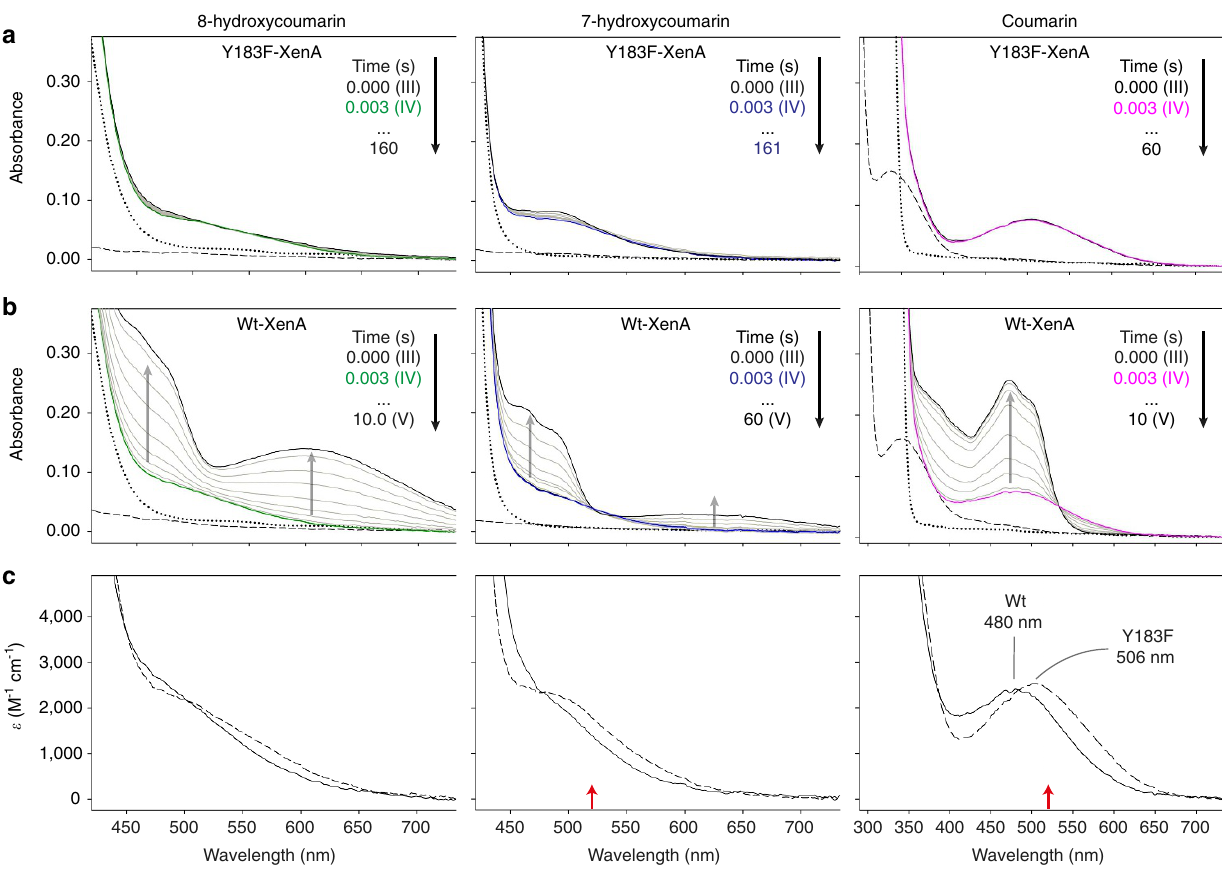
Figure 2 | Kinetics of the reoxidation of XenA. Time-dependent spectral changes for the reoxidation of 30 m M reduced ( a ) Y183F-XenA and ( b ) wild-type XenA by 8-hydroxycoumarin, 7-hydroxycoumarin and coumarin. The dashed and dotted lines represent the spectra of the reduced enzymes and substrate, respectively. Grey arrows indicate the direction of absorbance changes. The first spectra after 3ms represent the Michaelis complexes (IV) of the oxidative half-reaction with 8-hydroxycoumarin (green), 7-hydroxycoumarin (blue) and coumarin (pink), respectively. The black bold spectra, obtained after complete reoxidation of reduced wt-XenA, correspond to the non-productive Michaelis complex mimics (V). ( c ) Spectral overlay of the reaction intermediates (Michaelis complexes; IV) of wt-XenA (solid-line) and Y183F-XenA (dashed line). The bathochromic shift in the Y183F-variant may reflect minor changes in the microenvironment due to the mutation. The red arrows indicate the excitation wavelength used in RR